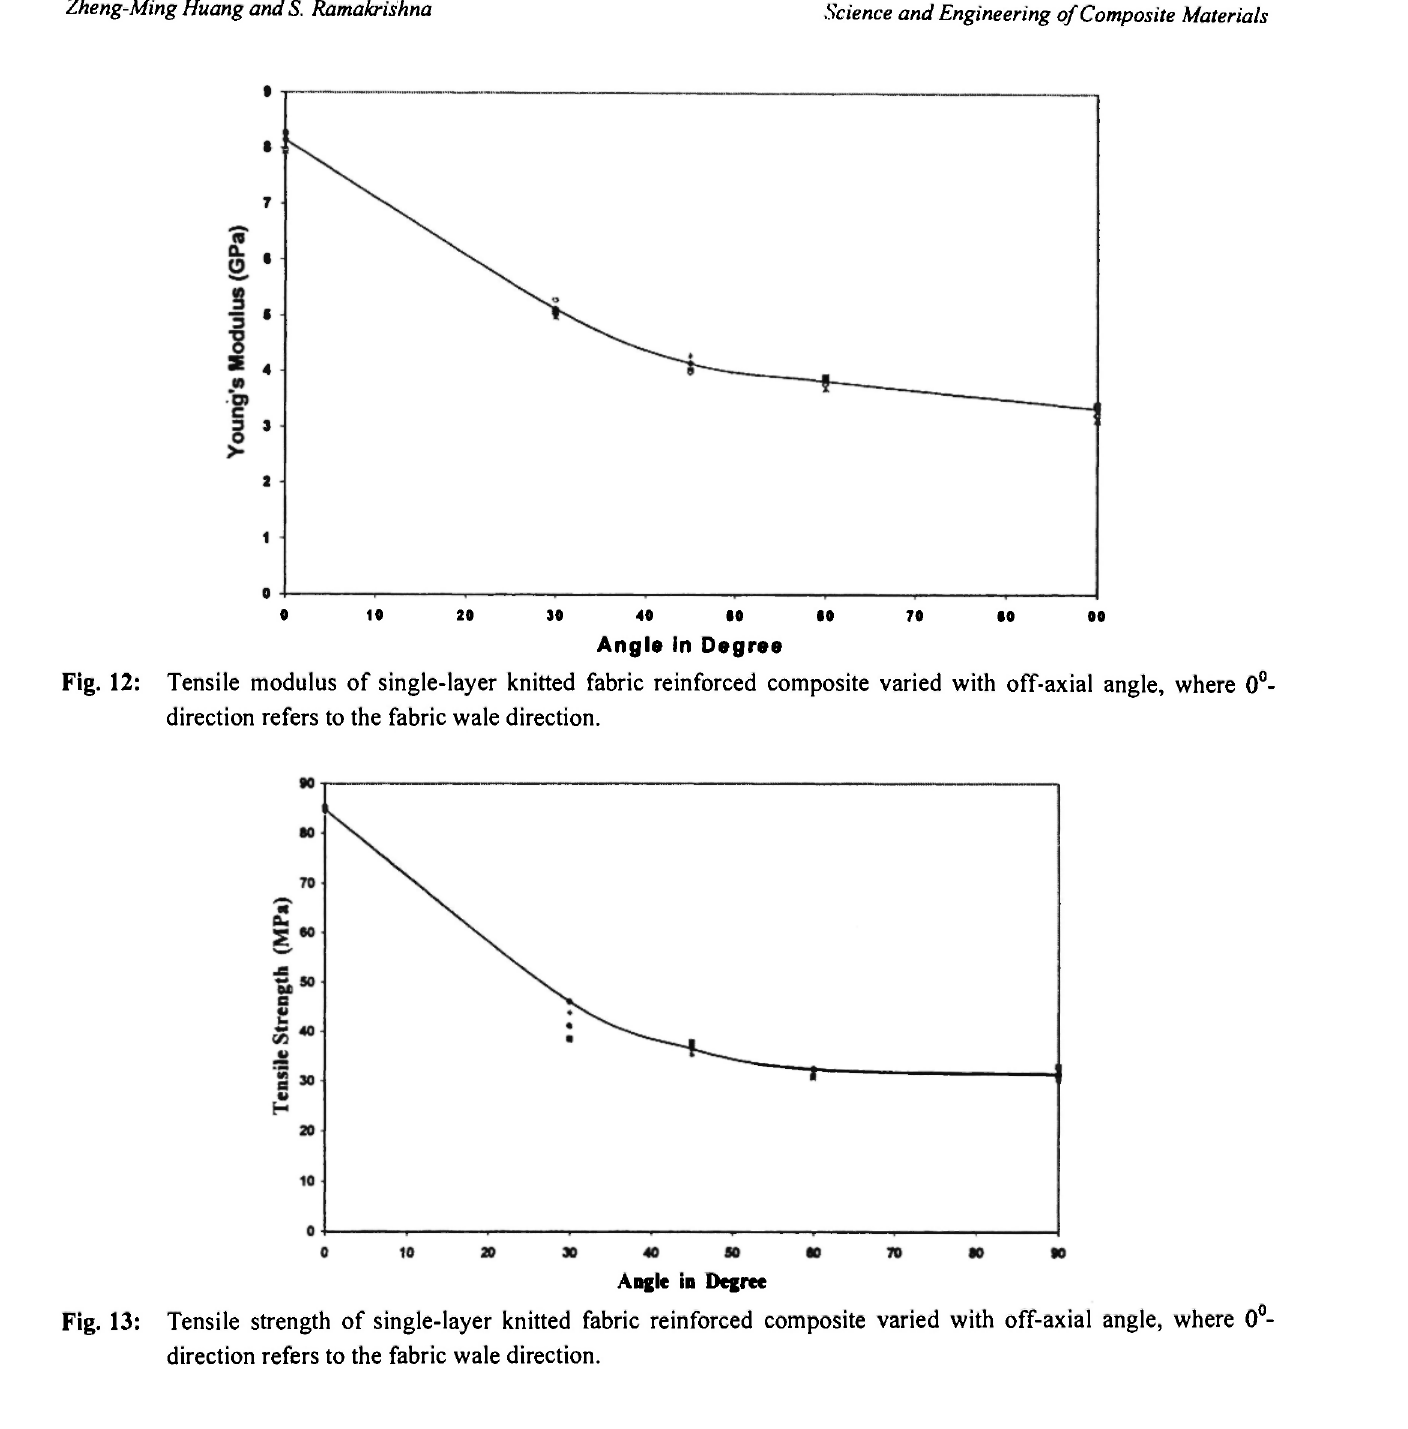
Fig. 13: Tensile strength of single-layer knitted fabric reinforced composite varied with off-axial angle, where in- direction refers to the fabric wale direction.